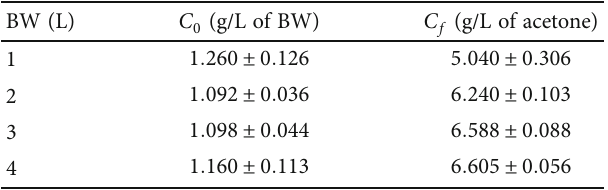
Table 1: Concentration of the extracts in three volumes of blanching water (1-3L) before adsorption expressed in g/L of BW and after adsorption expressed in g/L of